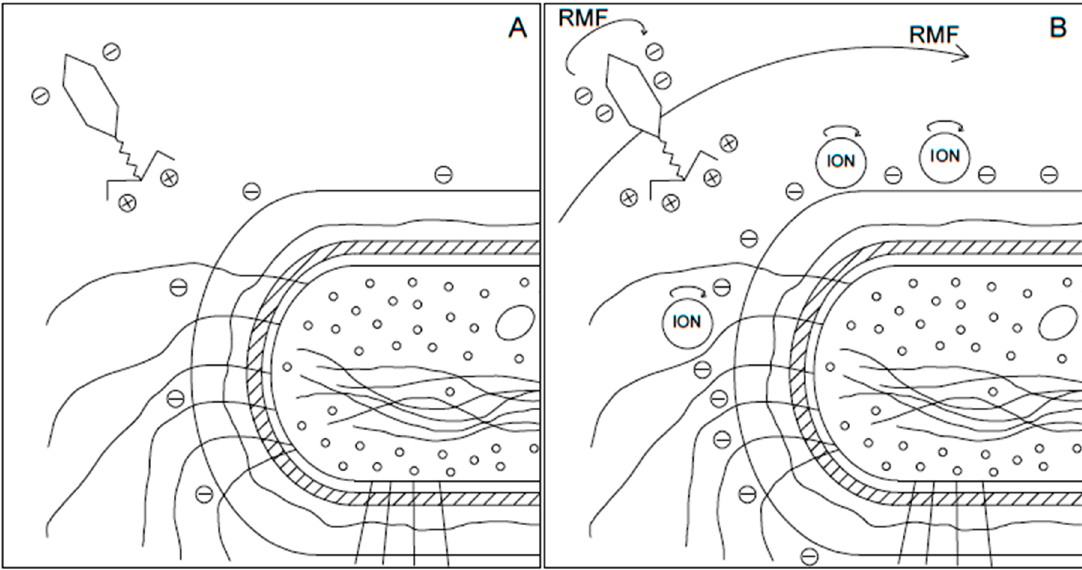
Figure 4. The visualization of the concept of RMF action on bacteriophage adsorption: ( A ) Adsorption process without RMF, ( B ) adsorption process with RMF.